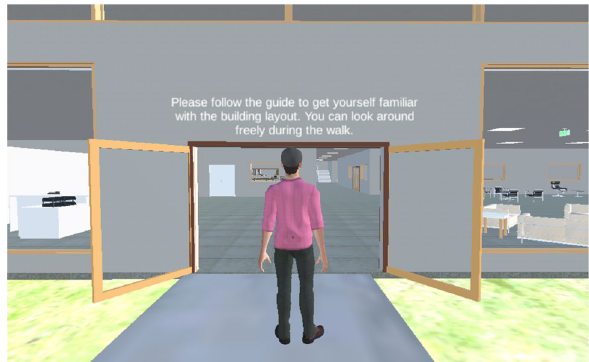
Figure 3. Virtual tour guide for the building